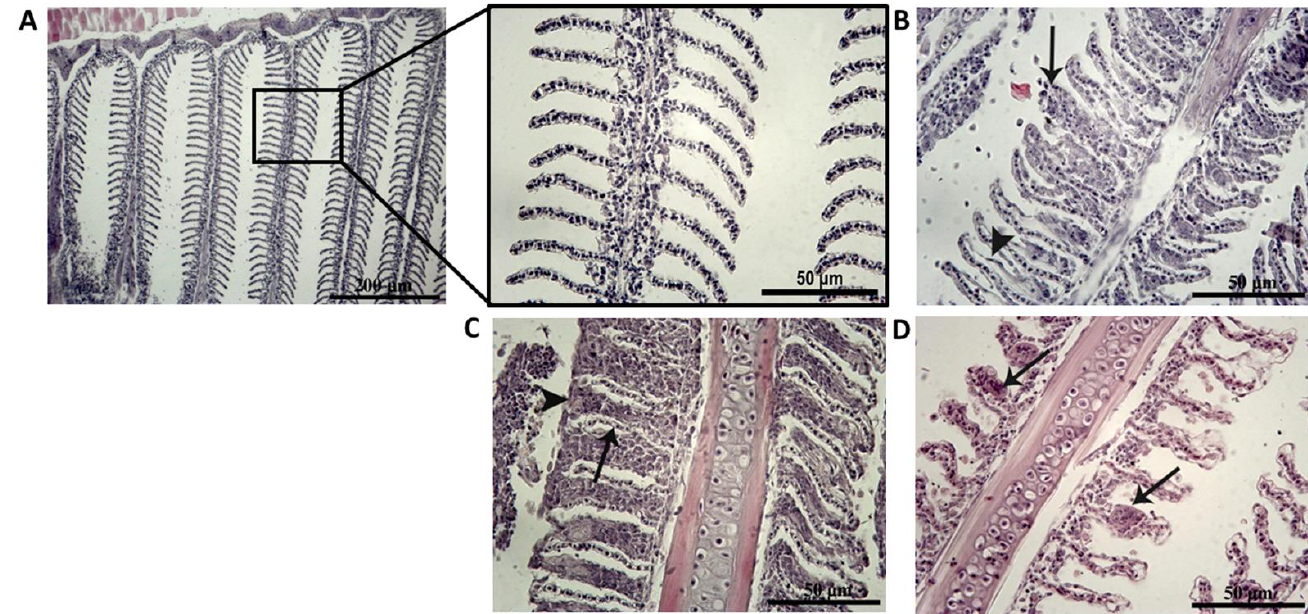
Figure 3. Histological lesions detected in the gills of the freshwater fish species Alburnus vistonicus in Vistonis Lake (Northern Greece), during the period October 2014–September 2015. ( A ) November sampling. Normal gills architecture. ( B ) April sampling. Hyperplasia of the primary lamella (arrow) and epithelium detachment (edema) of the secondary lamella (arrowhead). ( C ) April sampling. Hyperplasia of the primary lamella (arrowhead). Arrow shows a secondary lamella. ( D ) June sampling. Aneurysm of the secondary lamella (arrows). Table 1. Presence (+) and absence (−) of histological lesions detected in gill samples of the freshwater fish species Alburnus vistonicus in Vistonis Lake (Northern Greece), during the period October 2014–September 2015 (no samples were obtained in January 2015 due to unfavorable weather conditions). Histological Lesion OCT NOV DEC FEB MAR APR JUN JUL AUG SEP Epithelium detachment (edema) at the secondary lamella Hyperplasia of the primary lamella Hyperemia (aneurysm) of the secondary